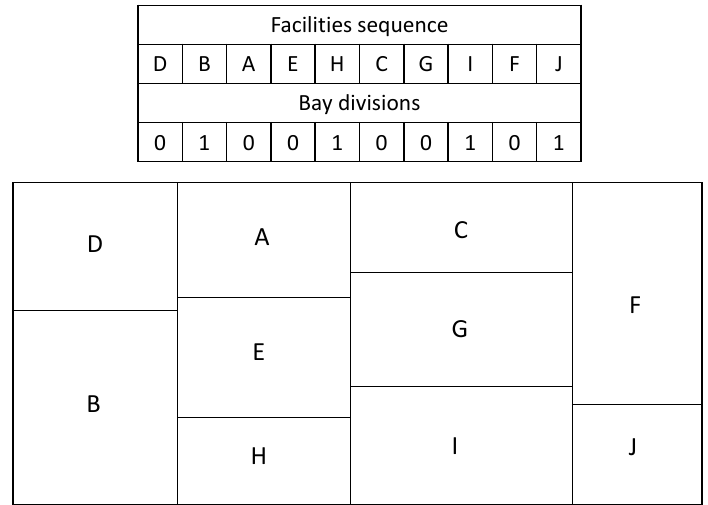
Figure 2. Facility layout codification